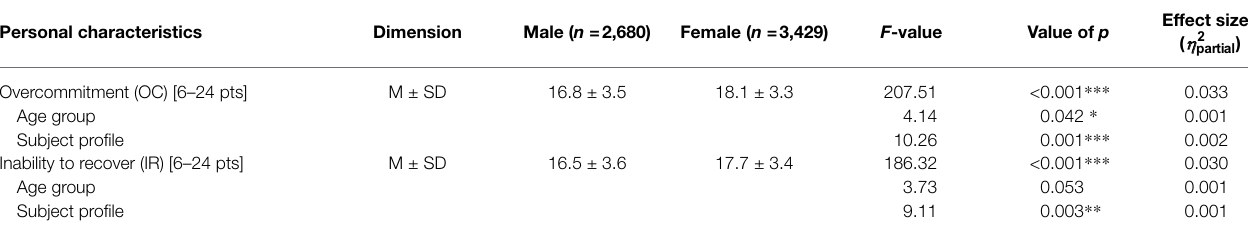
TABLE 3 | Main effects of personal characteristics and covariates (age groups and subject profile) of male and female full-time